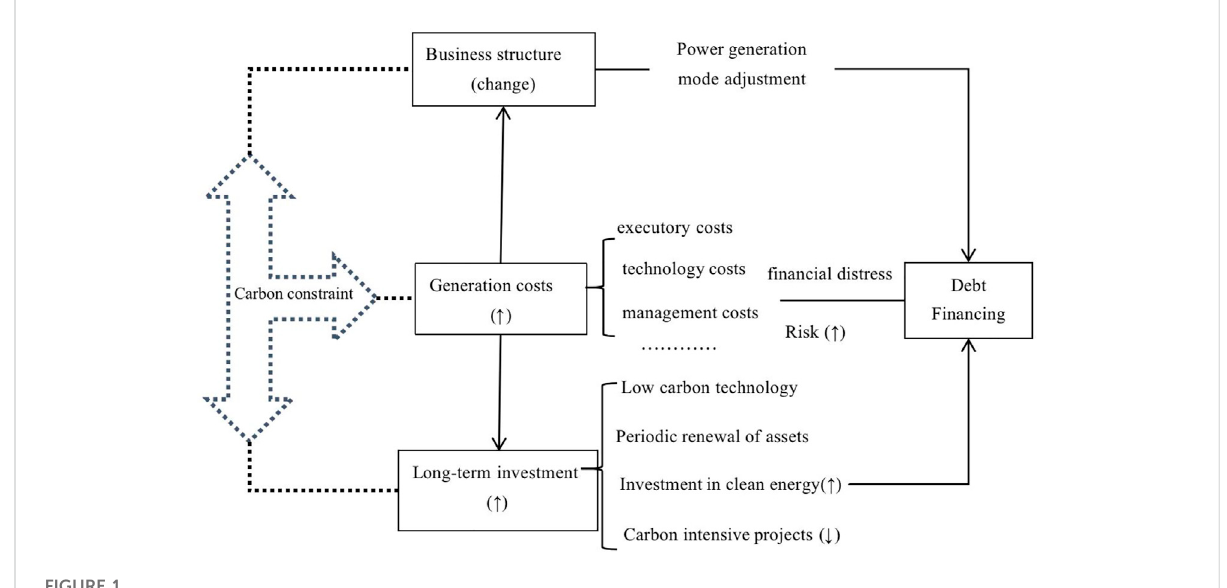
FIGURE 1 Impact mechanism of carbon constraints on debt fi nancing of power enterprises.